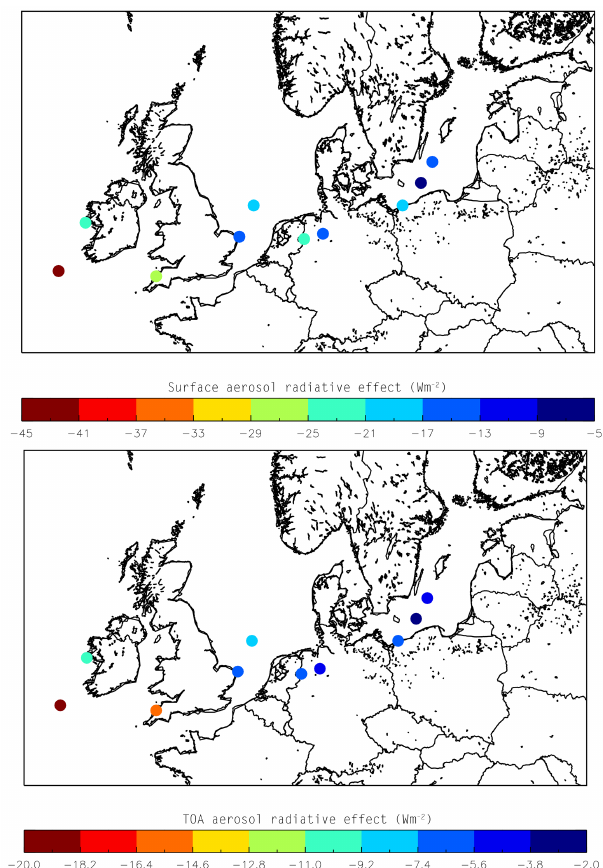
Figure 3. Aerosol radiative effect in Wm − 2 at the surface (top) and TOA (bottom) across north-western Europe during EUCAARI-